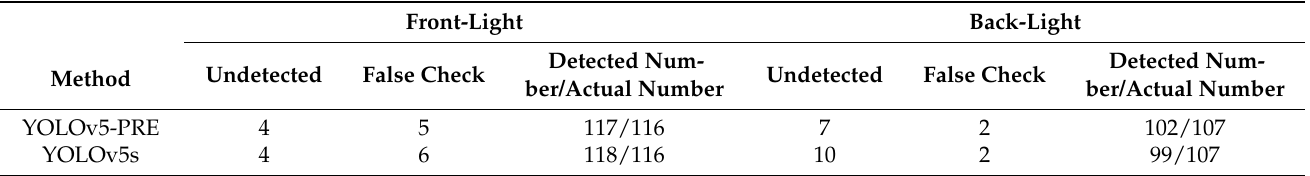
Figure 6. Comparison of recognition effect between YOLOv5-PRE and YOLOv5s. ( a ) Example of detection of fruit trees under front-light. ( b ) Example of detection of fruit trees under back-light. As presented in Table 5, YOLOv5s had a total of 118 targets in the front-light environ- ment, 4 missed detections and 6 false detections. As for the back-light environment target, was 2. Table 5. Comparison of missed and false detection between YOLOv5-PRE and